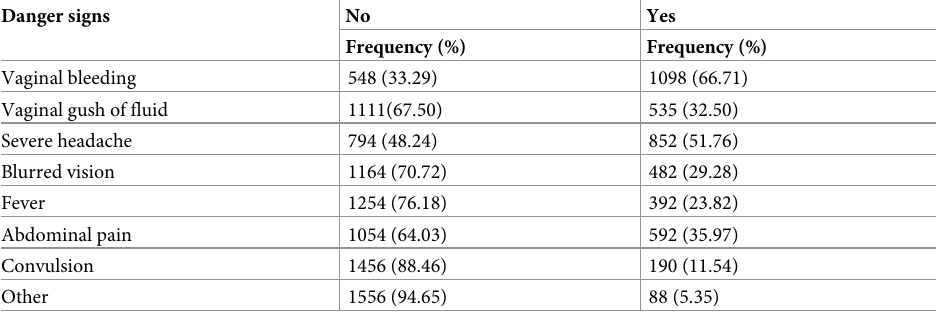
Table 3. Counseling on danger signs of pregnancy among women who received antenatal care service in Ethiopia.